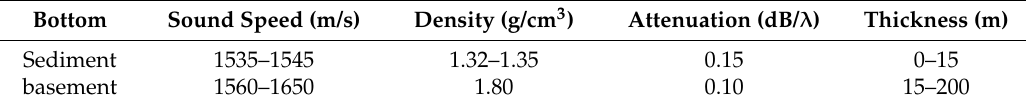
Table 1. Sediment and basement acoustic